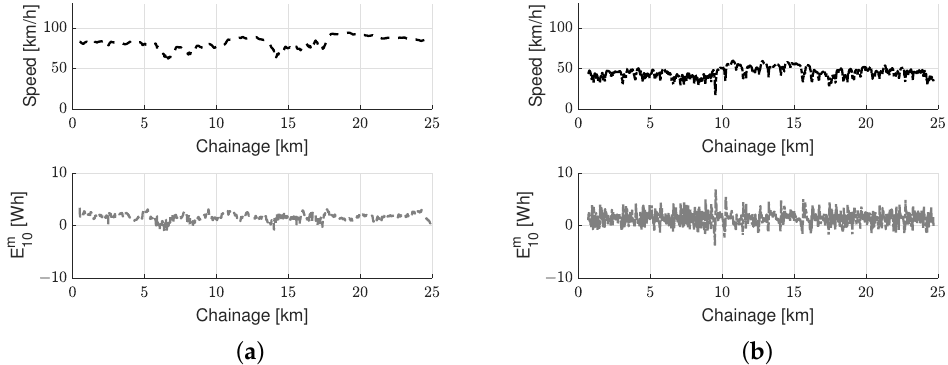
Average vehicle speed and measured traction energy from the GM cars traveling over the same road are visualized in Figure 6. The speed is shown as a black dashed line and dash-dotted line for the highway road and the urban road (respectively), and the traction energy as a grey dashed line and dashed-dotted line for the highway road and the urban road (respectively).